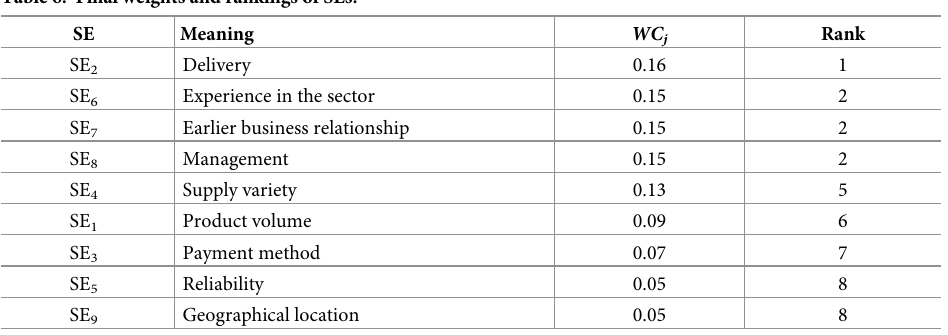
Table 6. Final weights and rankings of SEs.